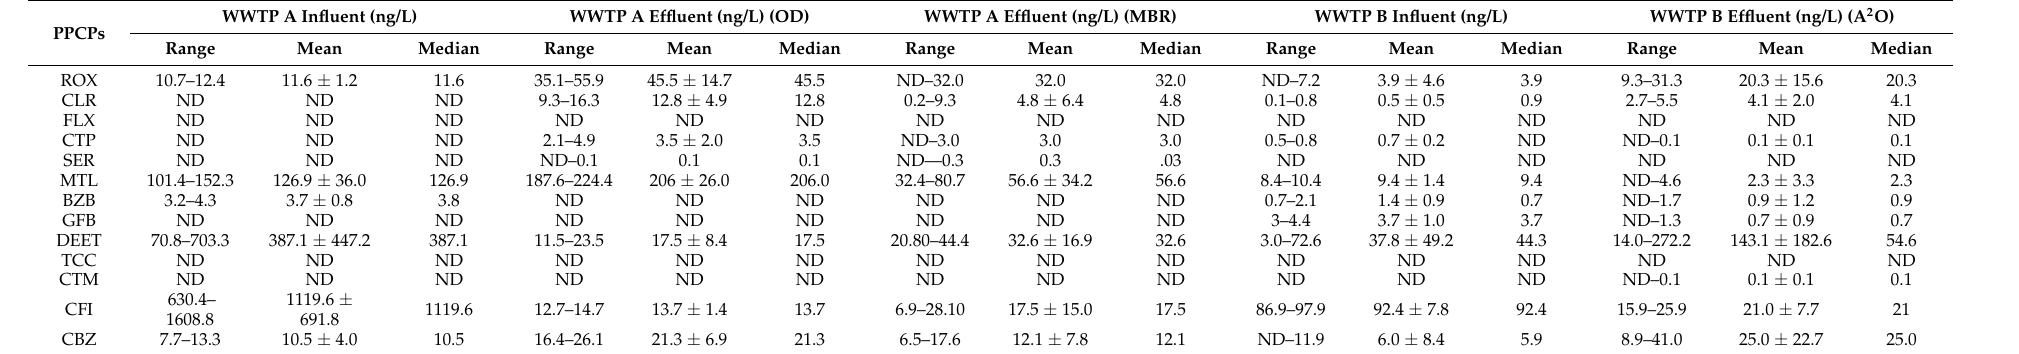
Table 1. Range and mean concentrations (ng/L) of PPCPs in all the influent and effluent samples of